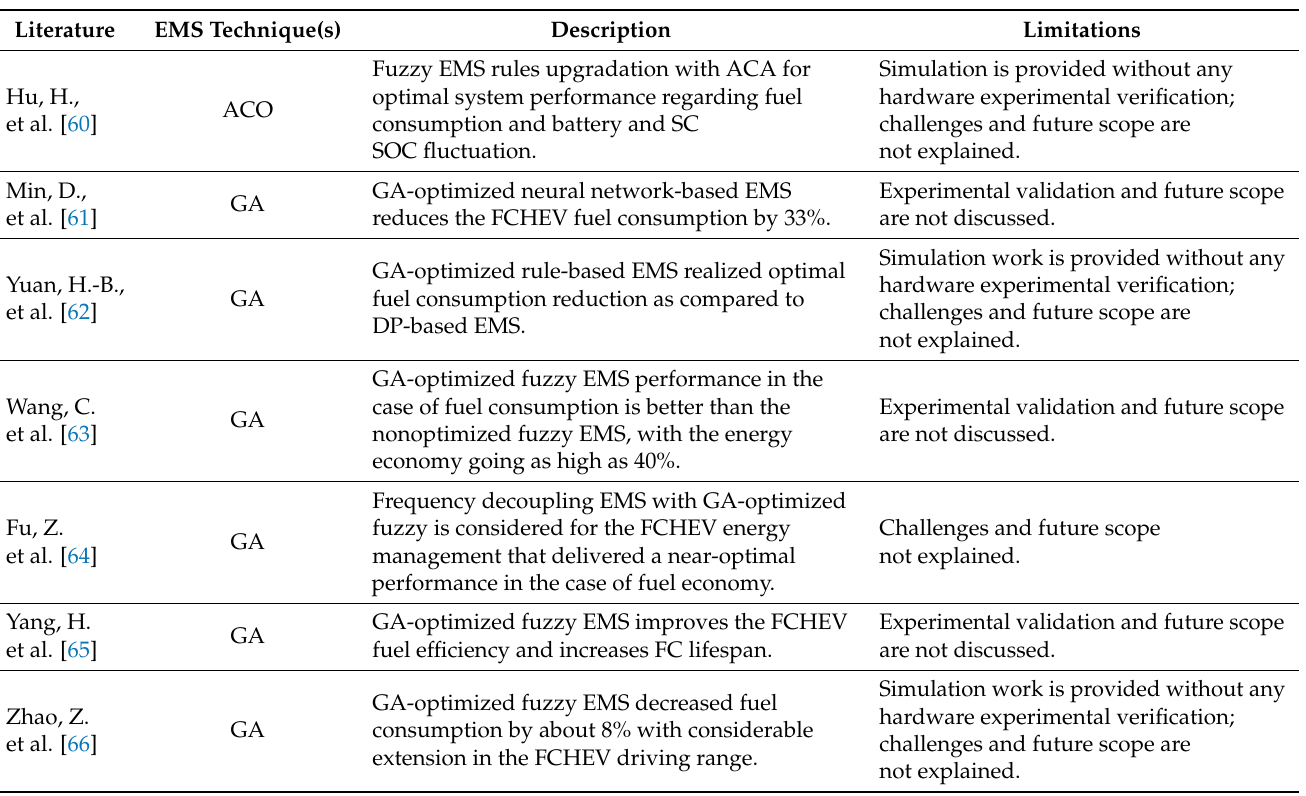
Table 6. Summary of the latest literature related to ACO- and GA-based EMSs.